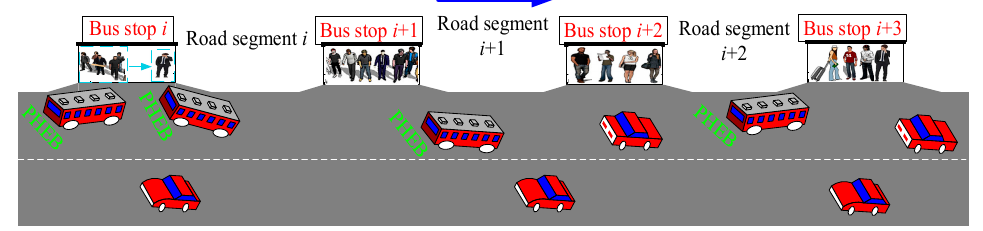
Figure 6. The route of the PHEB.